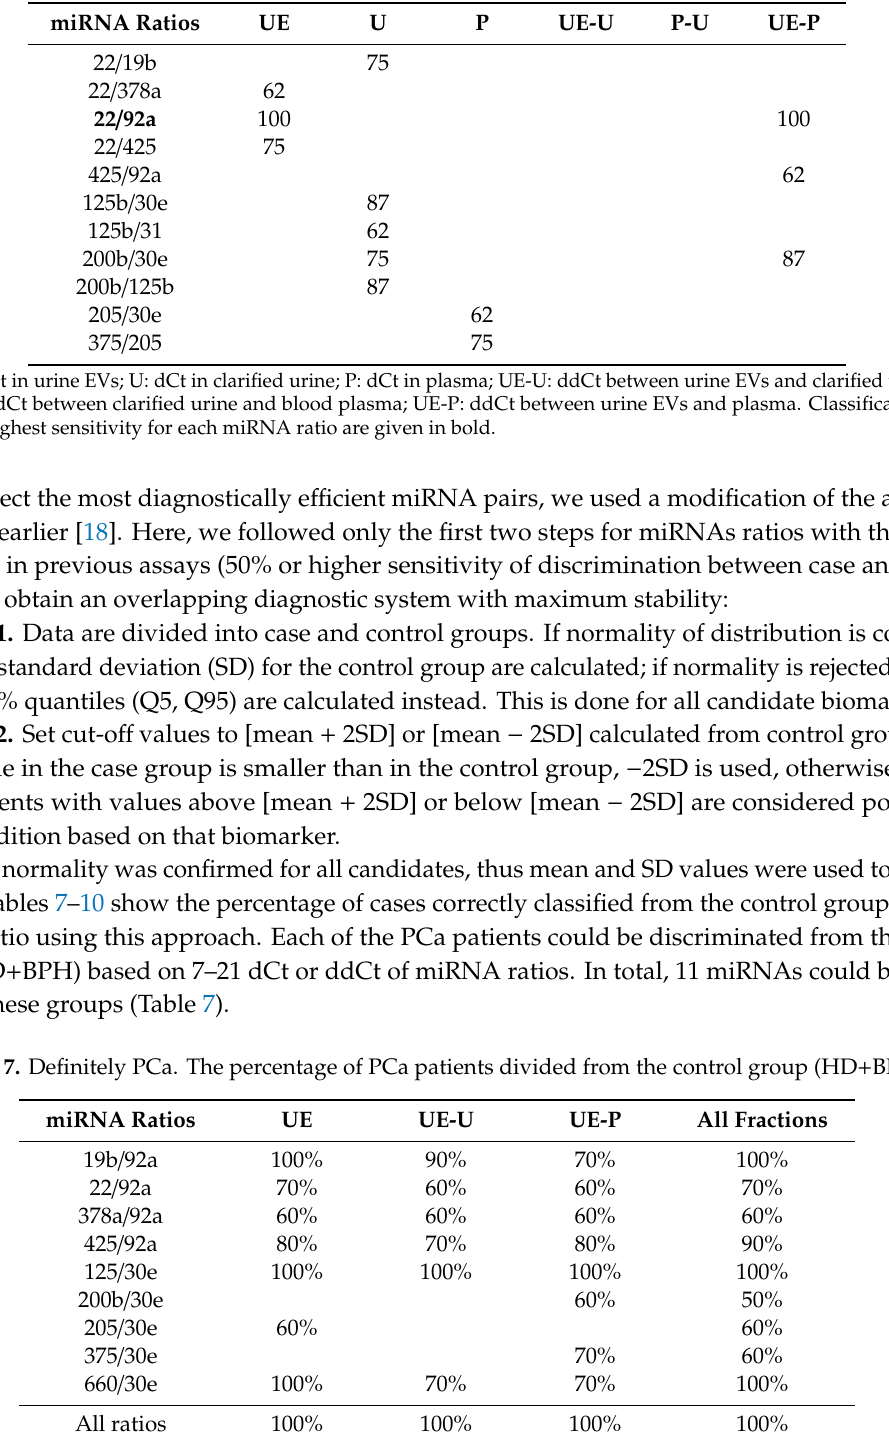
Table 6. ROC curve analysis: BPH vs. HD, sensitivity at 100% specificity.